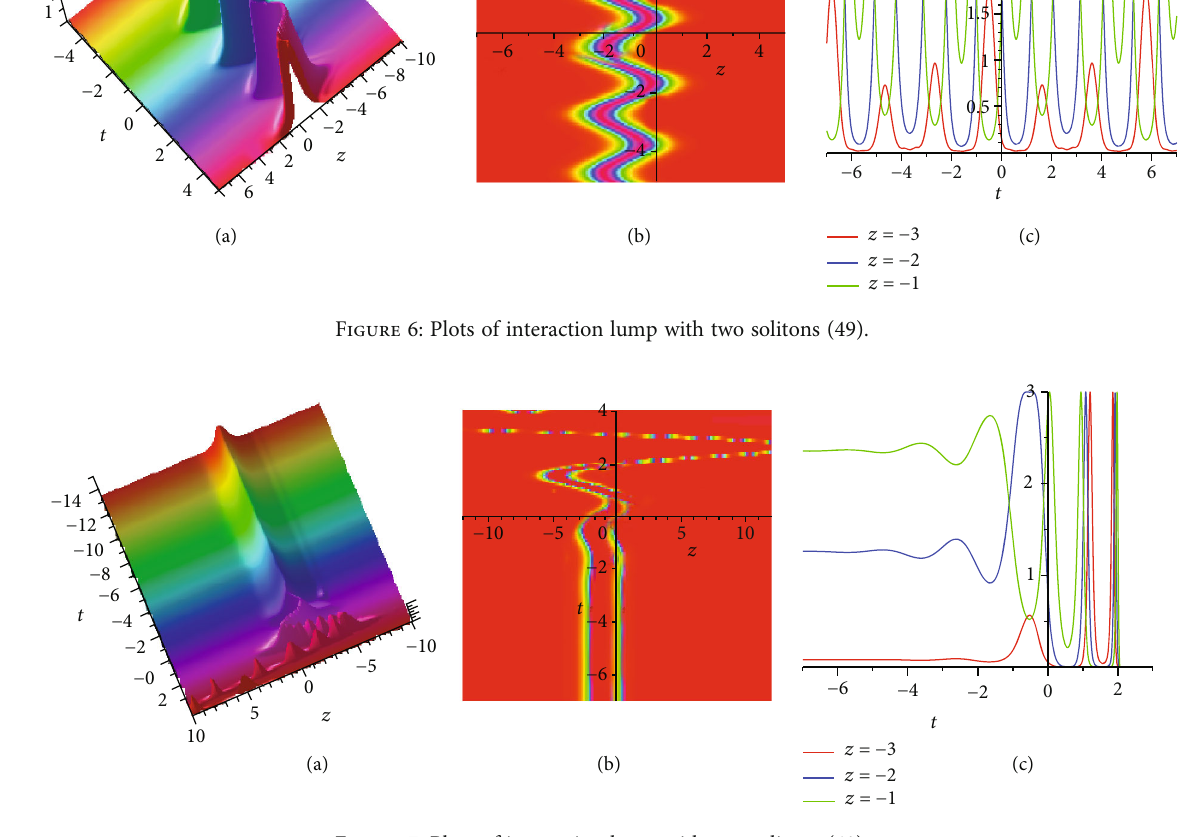
Figure 7: Plots of interaction lump with two solitons (49).